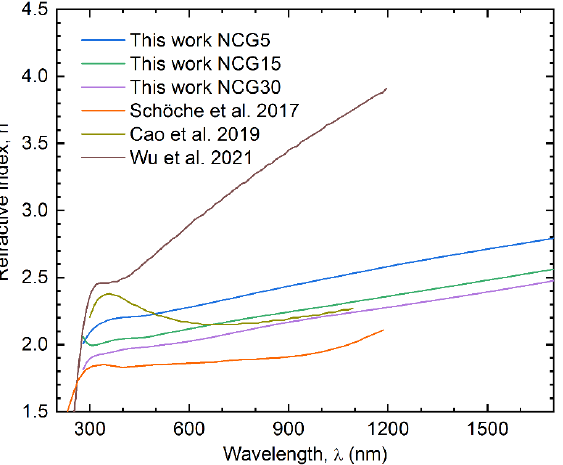
Figure 5. Comparison of the refractive index of graphene obtained from Refs. [13,16,17] with this work.